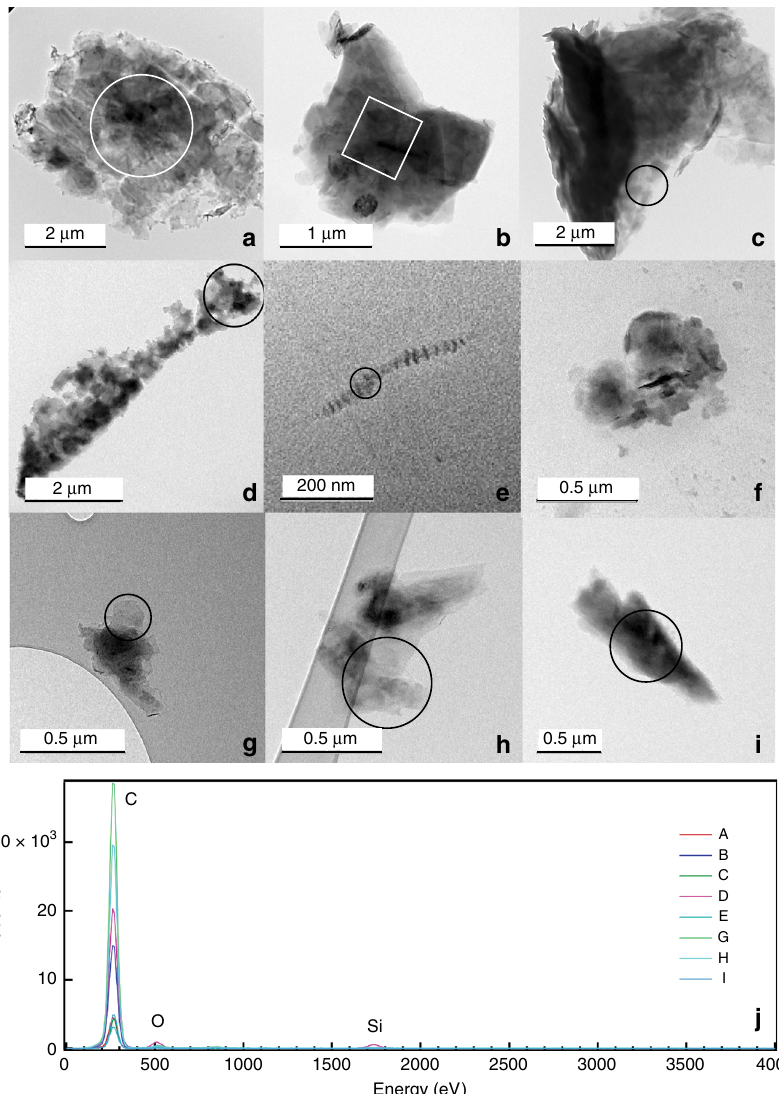
Fig. 1 Transmission electron microscopy (TEM) images of graphitic carbon particles. Particles were identi fi ed in high-temperature fl uids (Biovent, 335 °C, a , b ), hydrothermal plumes (within 1 m of the vent ori fi ce, Biovent, 15 °C, c – f , P Vent, 15 °C, g – h ), and diffuse fl ow (Q Vent, 35 °C, i ). Energy dispersive X- ray spectroscopy (EDS) spectra j taken from marked areas on particles show a common composition of carbon with trace oxygen and silicon, which likely represent background from the TEM grid and detector (Supplementary Information Fig. 1). No EDS spectrum was acquired from the particle in